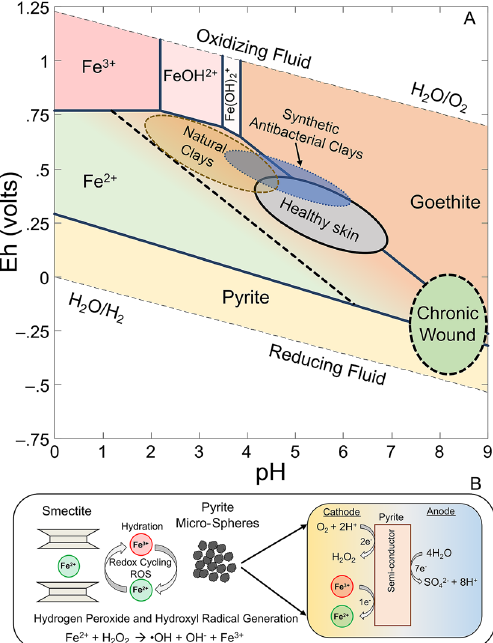
Figure 5. Pourbaix diagram of the Fe–S–O–H system and geochemical reactions that produce the antibacterial activity. (A) Plot of mineral and aqueous cation stability fields for Fe along with the pH and Eh ranges found in natural antibacterial minerals, synthetic antibacterial minerals, chronic wounds and healthy skin (see main text for references). The dashed line in the Fe 2+ stability field represents the shift in goethite stability that occurs as Fe concentrations increase due to the oxidation of pyrite and cation exchange of smectite interlayer spaces. Once the mineral system reaches thermodynamic equilibrium in an oxidizing environment, Fe 3+ -oxides (goethite) will form along with the loss of antibacterial activity. (B) Antibacterial mechanism of synthetic antibacterial mineral systems, showing the interplay of smectite cation exchange coupled to pyrite oxidation and redox cycling to maintain the generation of soluble Fe 2+ and reactive oxygen